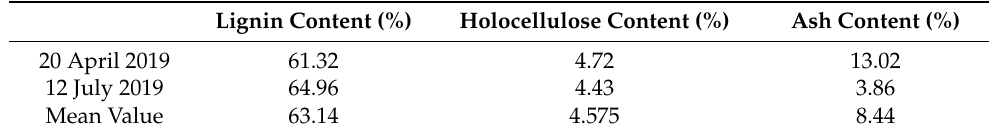
Table 1. Lignin, holocellulose, and ash content of WAW in NH.W2 in April and July 2019.